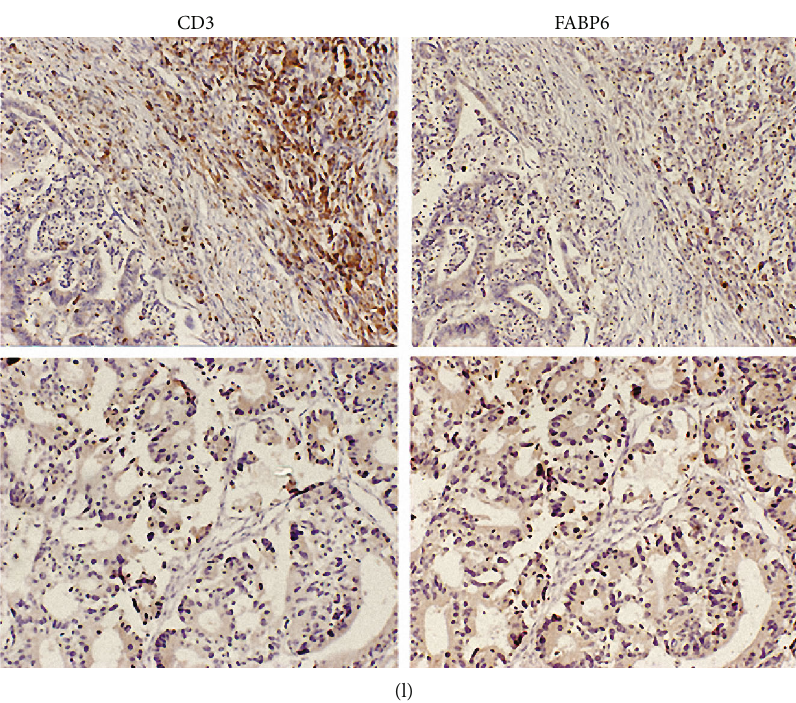
Figure 8: Inhibition of FABP6 promotes the immunogenicity of tumor cells. (a, b) Relative mRNA expression of immune-related genes in tumor cells. (c, d) ELISA analysis showed the secretion of CCL5 and CXCL9 in tumor cells. (e – h) Immuno fl uorescence analysis of HLA-A/ B/C in tumor cells. (e) and (g) are representative images; (f) and (h) are statistical analysis of the intensity. (i) Flow cytometry analysis showed HLA-A/B/C expression with FABP6 knockdown in tumor cells. (j – l) Transwell analysis of CD8+ T cells; (j) is representative images, and (k) is the statistical analysis of CD8+ cell numbers. (l) IHC analysis of FABP6 and CD3 expression in clinical samples. ∗ P < 0 : 05 ; ∗∗ P < 0 : 01 ; ∗∗∗ P < 0 : 001